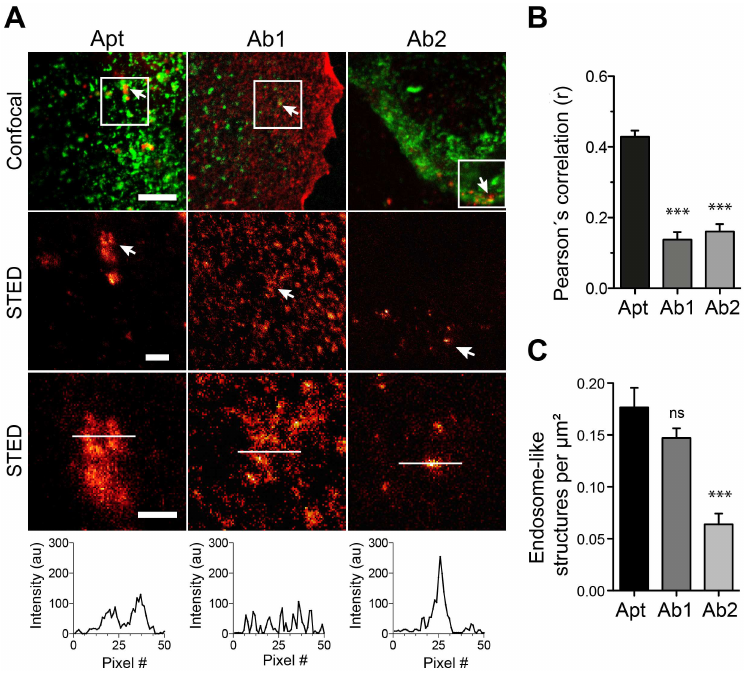
Fig 6. Recognition of subcellular structuresusing STED microscopy in aptameror antibody stained samples against EGFR. (A) Sets of confocaland STED images of aptamers (Apt, red) or the antibodies Ab1 and Ab2 (red) co-stainedwith Alexa488-Transferrin (green). The first row of images shows confocalco- localization examples. The followingrows of images show STED examplesat different zooms from the white squaredelineatedon the confocalimages. A line scan of 50 pixels was drawn (white line) on the endosome- like structures. The line-scanintensity profile is displayed. ( B ) Pearson’scorrelation coefficients (r) on confocalimages obtainedafter staining with aptamers or antibodieswith the Alexa488-Transferrinmarker. ( C ) Quantification of endosome-like structures found in STED images for aptamer stainings(Apt) and for the antibodies (Ab1 & Ab2). All graphs(for B and C) show the mean values and S.E.M of 3 independent experiments. Statistical significances were calculatedusing one-way Anova and Dunnett’s multiple comparisons post hoc tests (ns, not significant; * p < 0.05; ** p < 0.01; *** p < 0.001). Scale bars from top to bottom row: 5, 1 and 0.5 μ